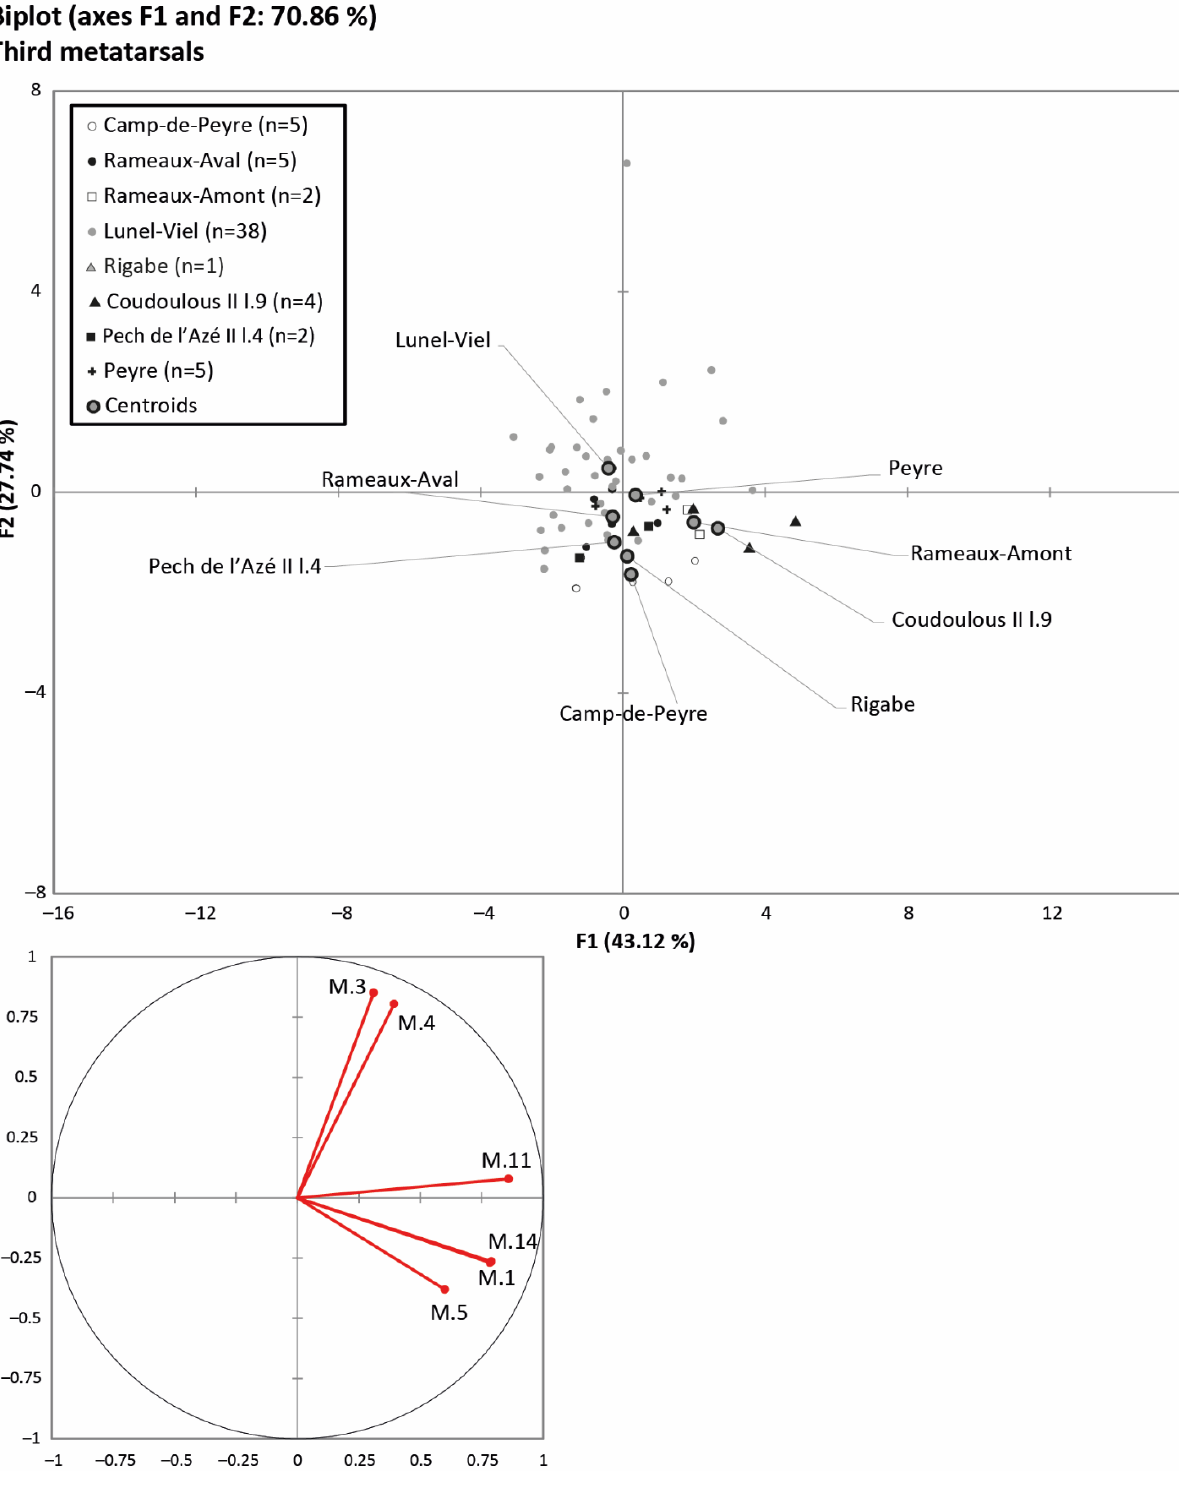
Figure 6. Principal component analysis (PCA) with measurements of the third metatarsals of southern Middle and Late Pleistocene horses from the caballoid lineage. The correlation circle illustrates the contribution of each variable. M. 1: Maximal length, M. 3: Breadth at the middle of the diaphysis; M. 4: Depth of the diaphysis at the same level; M. 5: Proximal breadth; M. 11: Distal articular breadth; M.14: Greatest depth of the medial condyle. The large dots correspond to the centroid of each cohort. Camp-de-Peyre: E. m. campdepeyri ; Rameaux-Aval and Amont: E. mosbachensis ; Lunel-Viel: E. m. palustris ; Rigabe: E. m. palustris ; Coudoulous II l.9: E. mosbachensis ; Pech de l’Azé II l.4: E. caballus ; Peyre: E. caballus.